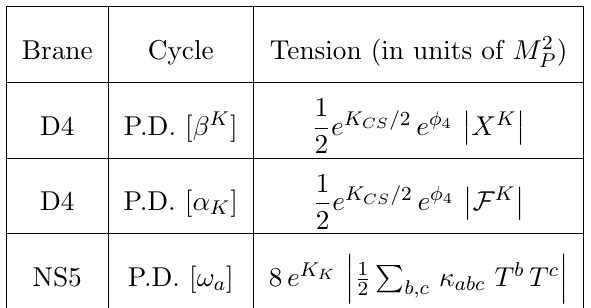
Table 4. Tensions of 4d strings formed by D4 and NS5-branes wrapping the indicated internal